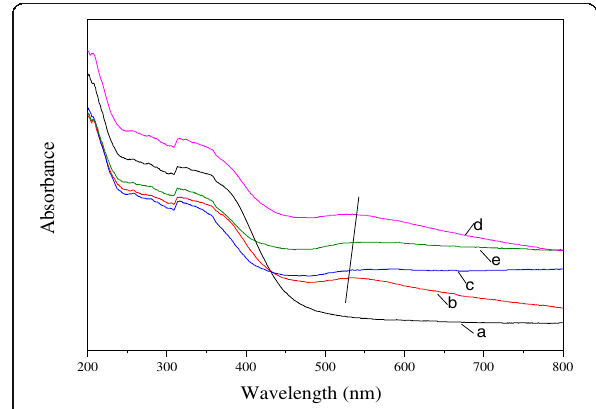
Fig. 7 UV-vis DRS of pure Ce 0.75 -La 0.25 nanorod support (a) and 0.3% Au/Ce 0.75 -La 0.25 nanorods calcined at 80 °C (b), 200 °C (c), 300 °C (d), and 400 °C